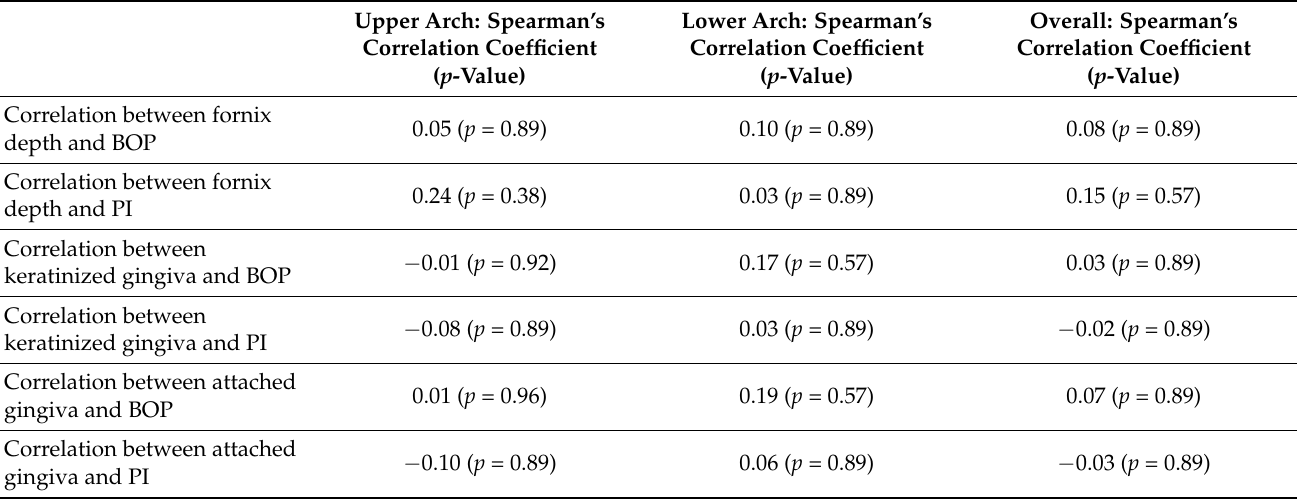
Table 2. Correlations between anatomical parameters (fornix depth, width of keratinized gingiva, and attached gingiva) and periodontal health parameters (BOP and